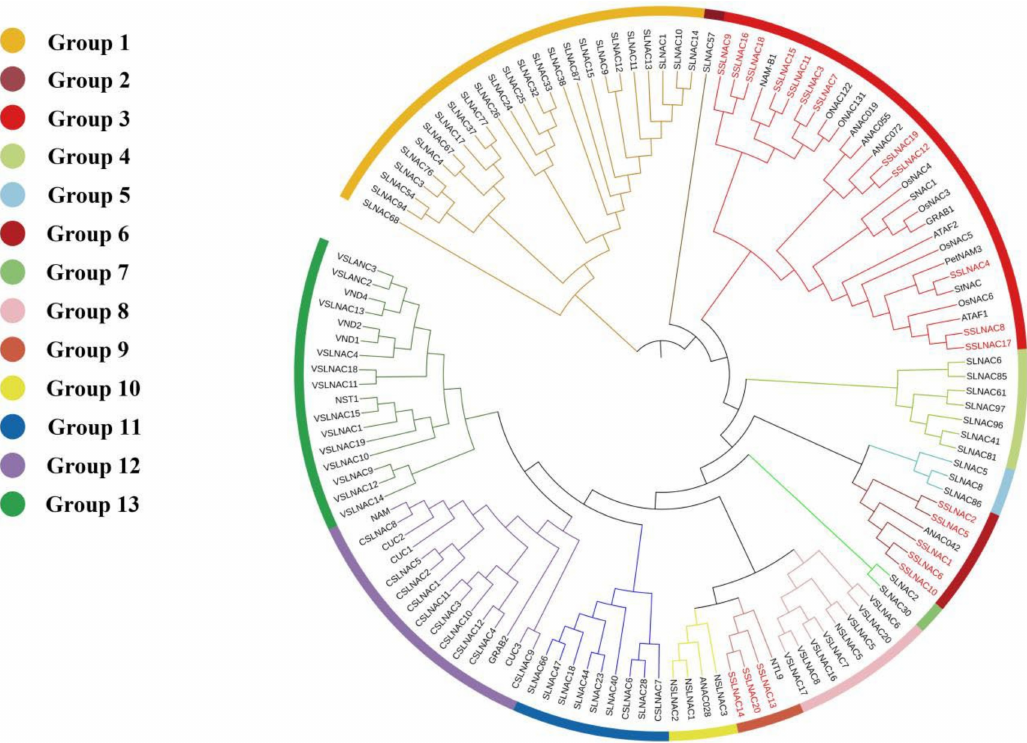
Figure 1. The phylogenetic tree of the 101 NAC genes in tomato and the NAC genes related to biotic/abiotic stresses in rice and Arabidopsis. The neighbor-joining (NJ) phylogenetic tree was constructed using MEGA software version 5.05 with 1000 bootstrap replicates. They are divided into 13 groups, labeled with different colors, and the 20 putative stress SlNAC genes ( SSlNAC1 – 20 ) are indicated in red